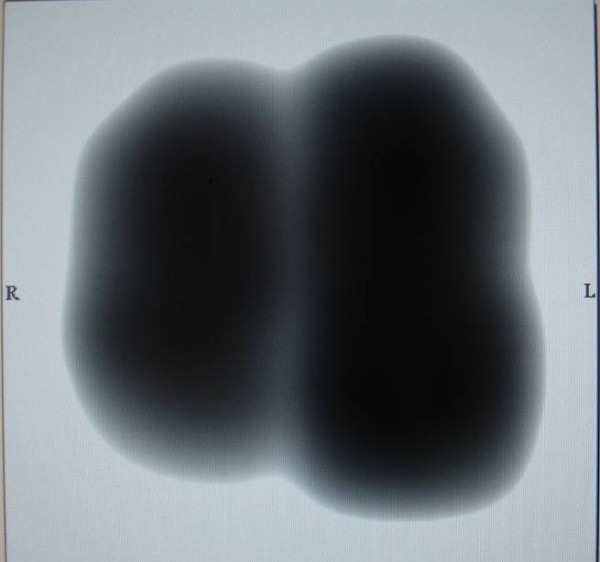
Vibration response imaging (VRI) obtained from the same patient (Figure 2). VRI shows the breath sound intensity distribution at the maximum energy frame (MEF). The missing part in the right lower field shows the area of pneumonia.